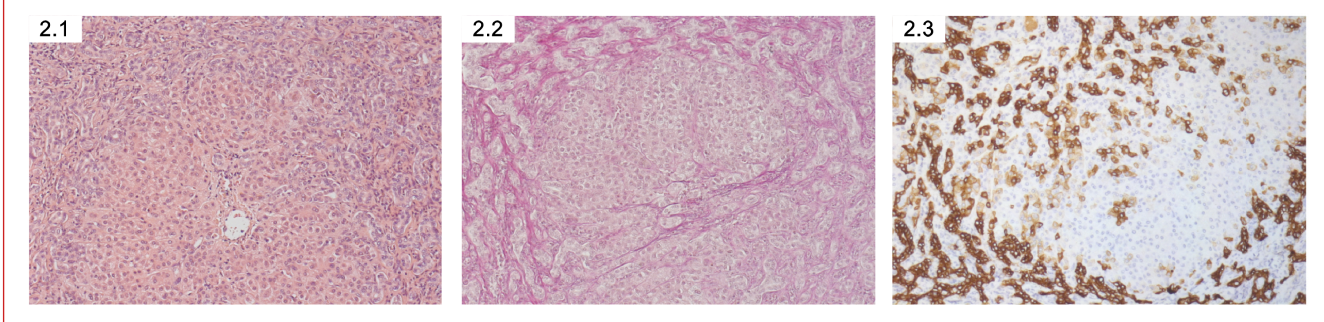
Fig 2. Histopathology of the liver in cardiac hepatopathy. Severe liver cirrhosis and cholestasis with an increase of bile ductus were shown using hematoxylin and eosin stain (2.1, 2.2) and immunohistochemical staining for cytokeratin 7 (2.3).